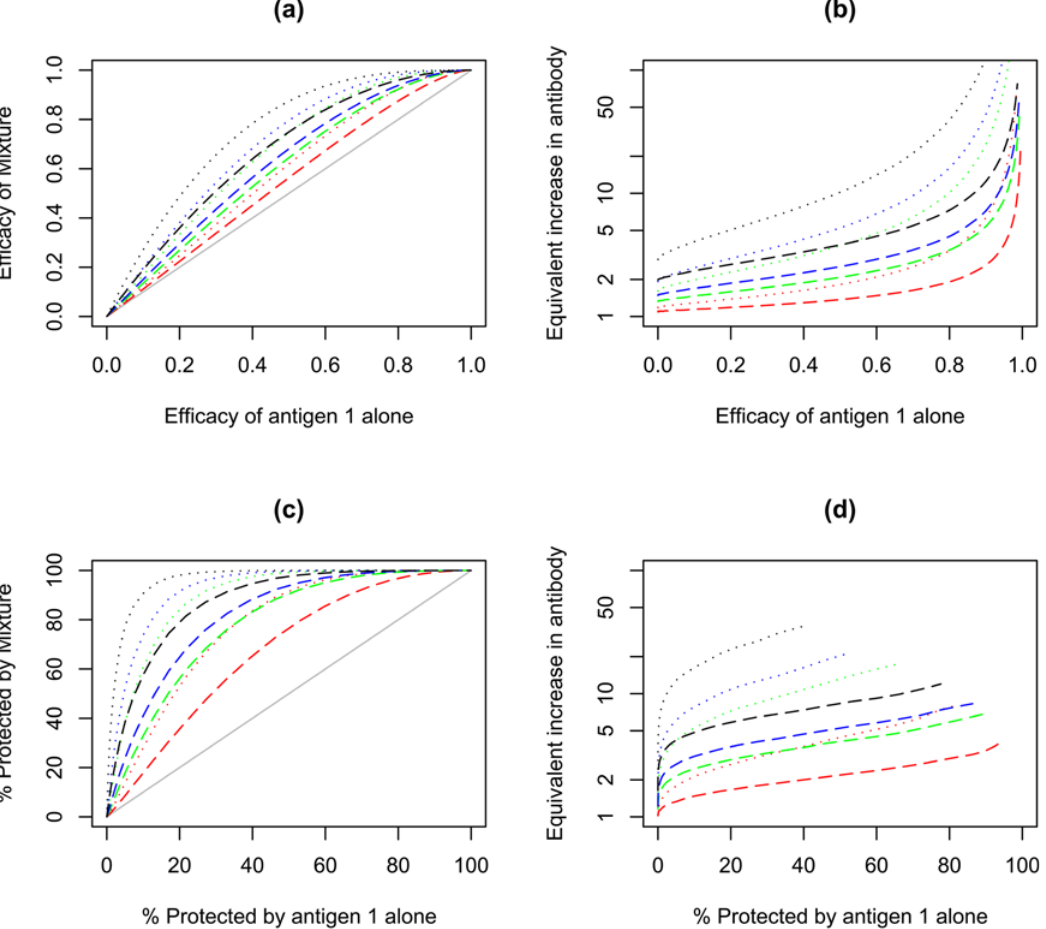
Figure 4. Effect using immunogens that elicit different levels of immunity in a two component (dashed lines) or three component (dotted lines) vaccines on efficacy and the percent population protected. Model assumes that the diversity of the immune response generated by each component is similar (fold range is 65 fold) and that the immune response to the individual components is not correlated. Vaccines contain a second or third immunogen that generate 1/10 (red), 1/3 (green), 1/2 (blue) or equal geometric mean immune responses (black) to the geometric mean of the first component. Other details are described in the Figure 3 legend.